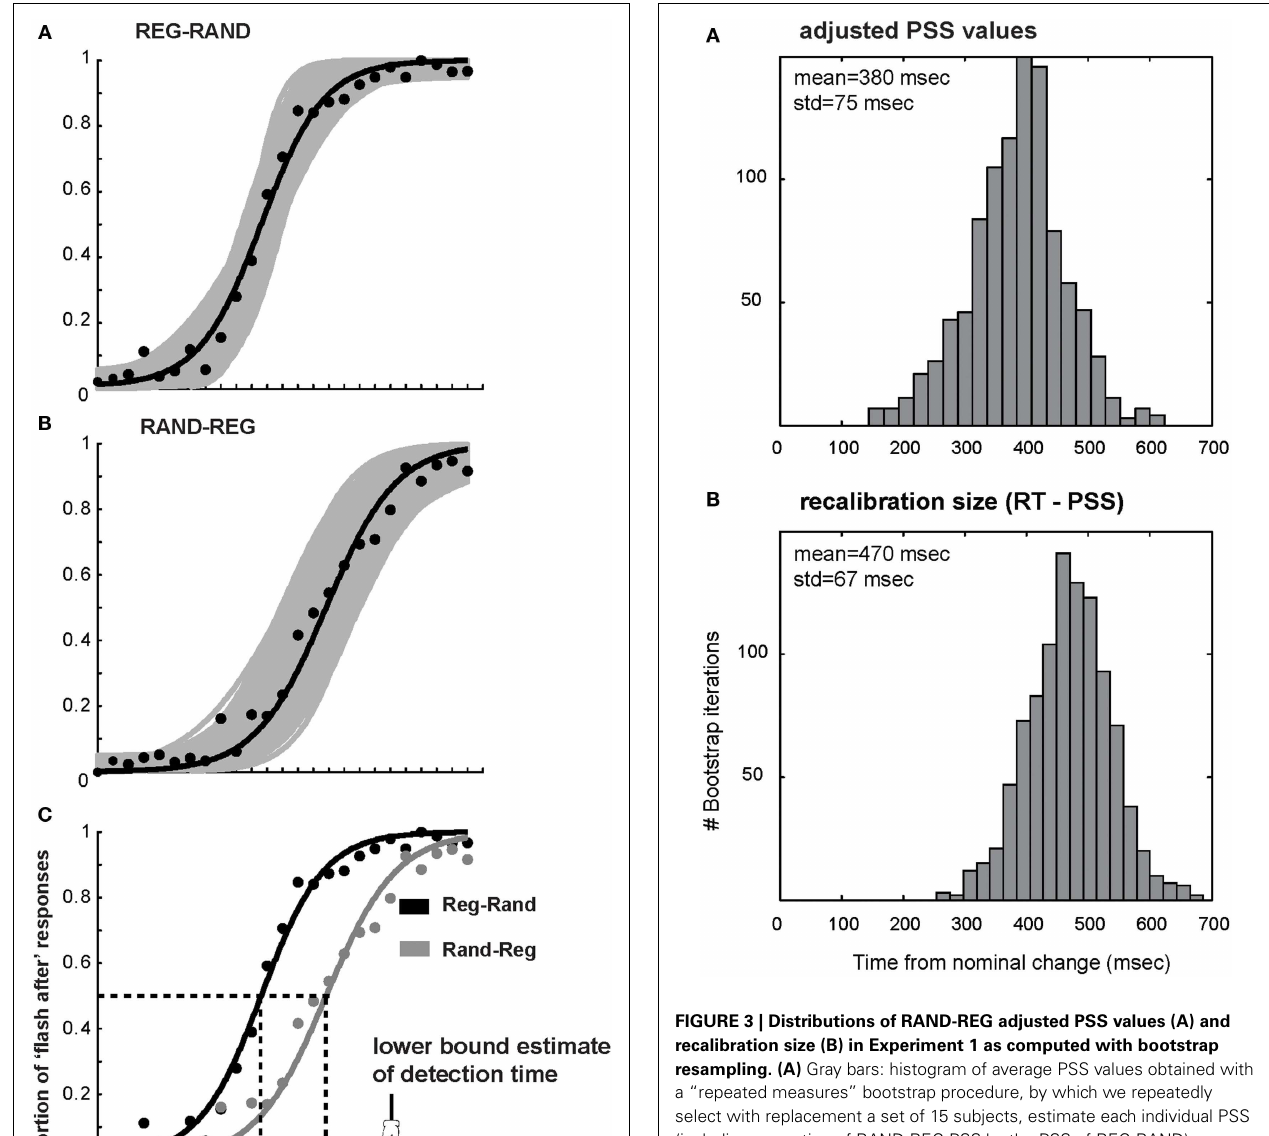
same processes as well as the extra processing time specific to that